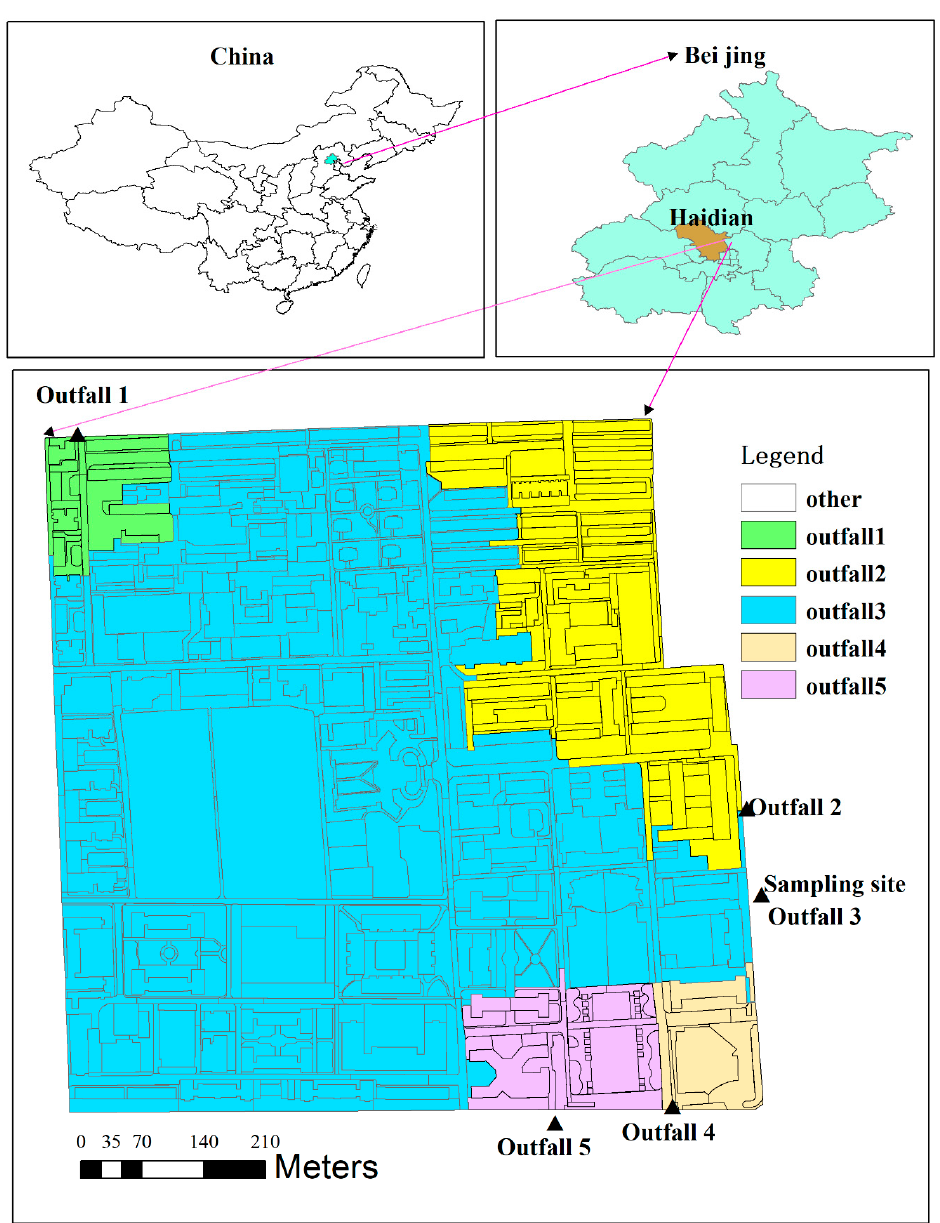
Figure 1. Study area and the locations of sampling site for FC. Green areas-the upstream of outfall 1, yellow areas-the upstream of outfall 2, blue areas-the upstream of outfall 3, orange areas-the upstream of outfall 4, purple areas-the upstream of outfall 5.